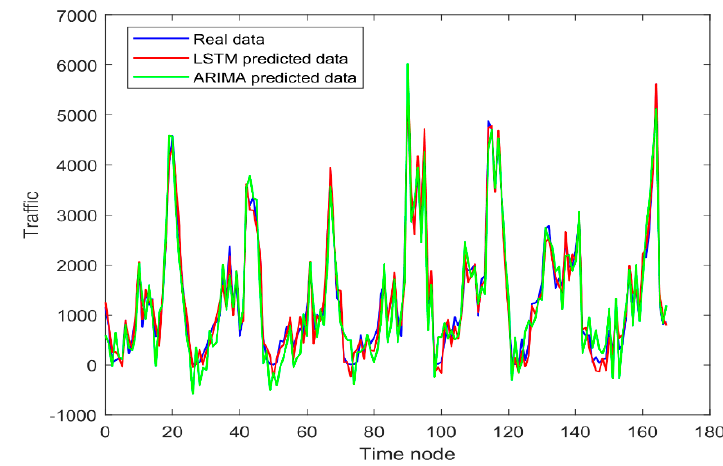
Figure 6. Traffic forecasting for BS Cell_000111.